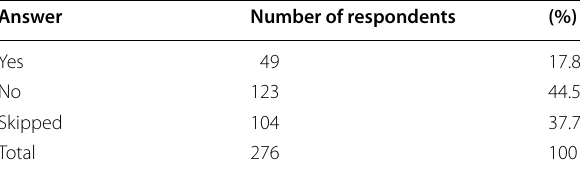
Table 3 Respondents with practical clinical experience with AI-based algorithms: main field of activity/subspecialty Field of practice